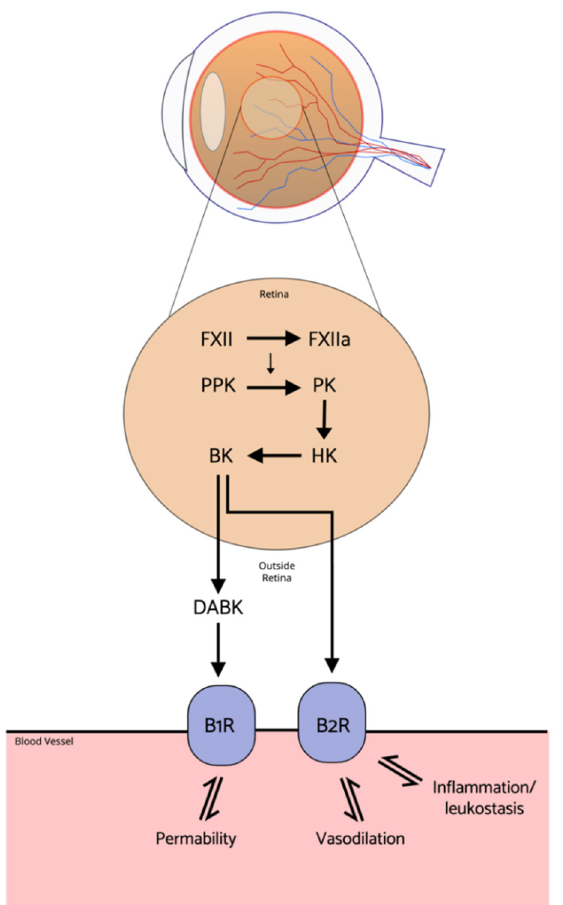
Figure 3. Potential action of the Kallikrein-kinin system (KKS) in DR. When the kallikrein-kinin system (KKS) is operational, Factor II (FXII) is converted and becomes Factor IIa (FXIIa) and plasma kallikrein (PK) and PK causes high-molecular-weight kininogen (HK) to separate into bradykinin (BK). BK then activates bradykinin 2 receptor (BR2) and then BK further separates into des-Arg BK (DABK), which goes on to activate bradykinin 1 receptor (BR1) [27]. Activation of these receptors leads to a downstream release of vasoactive molecules such as nitric oxide, prostacyclin, and cyclic guanosine monophosphate (cGMP), these molecules are understood to go on to cause the pathogenic effects of diabetic retinopathy